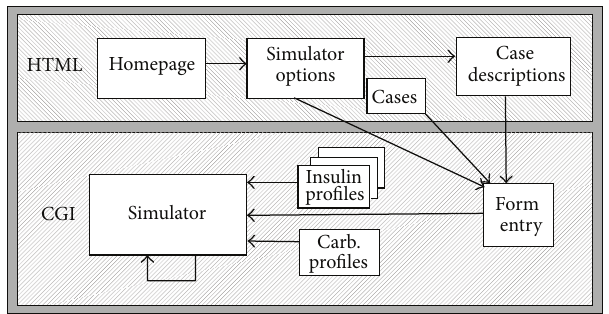
Figure 1: Basic structure of AIDA online. HTML =